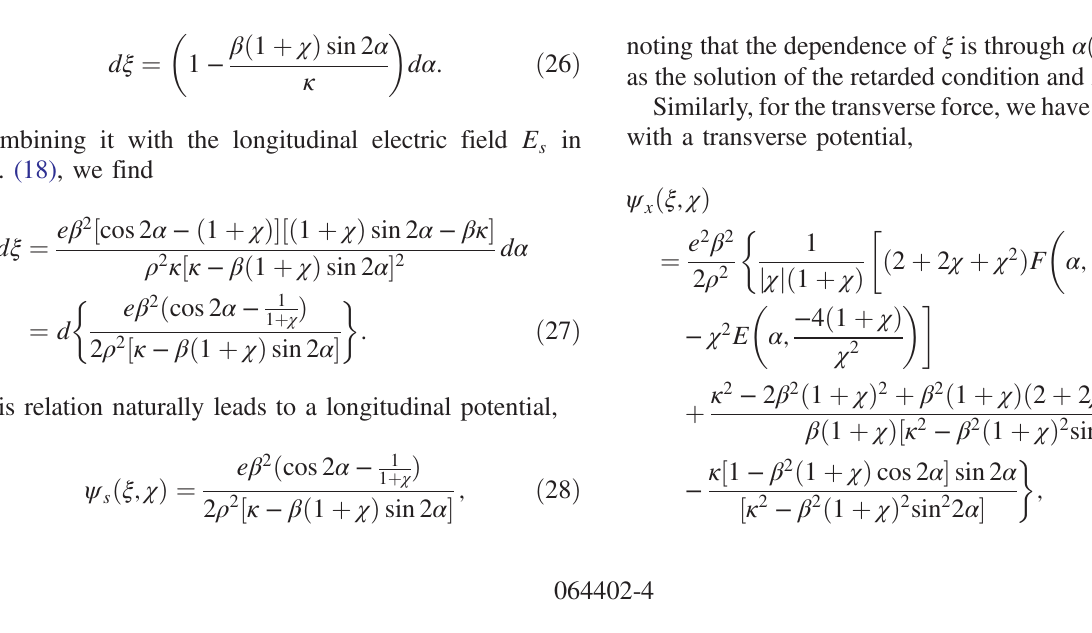
ρ 2 =e γ (left) and transverse potential ψ s